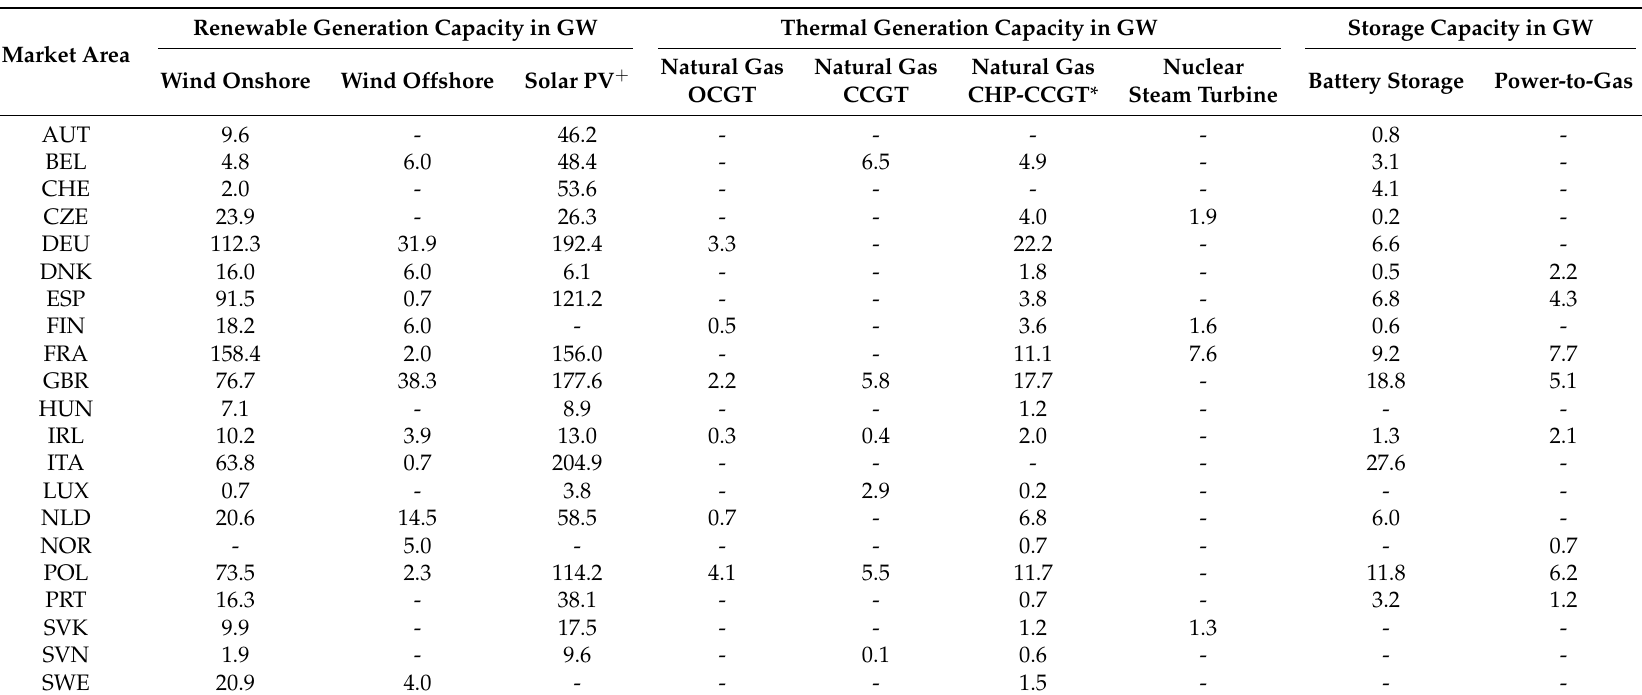
Table A1. Installed generation and flexibility capacity of decarbonised long-term energy scenario for all considered market areas in